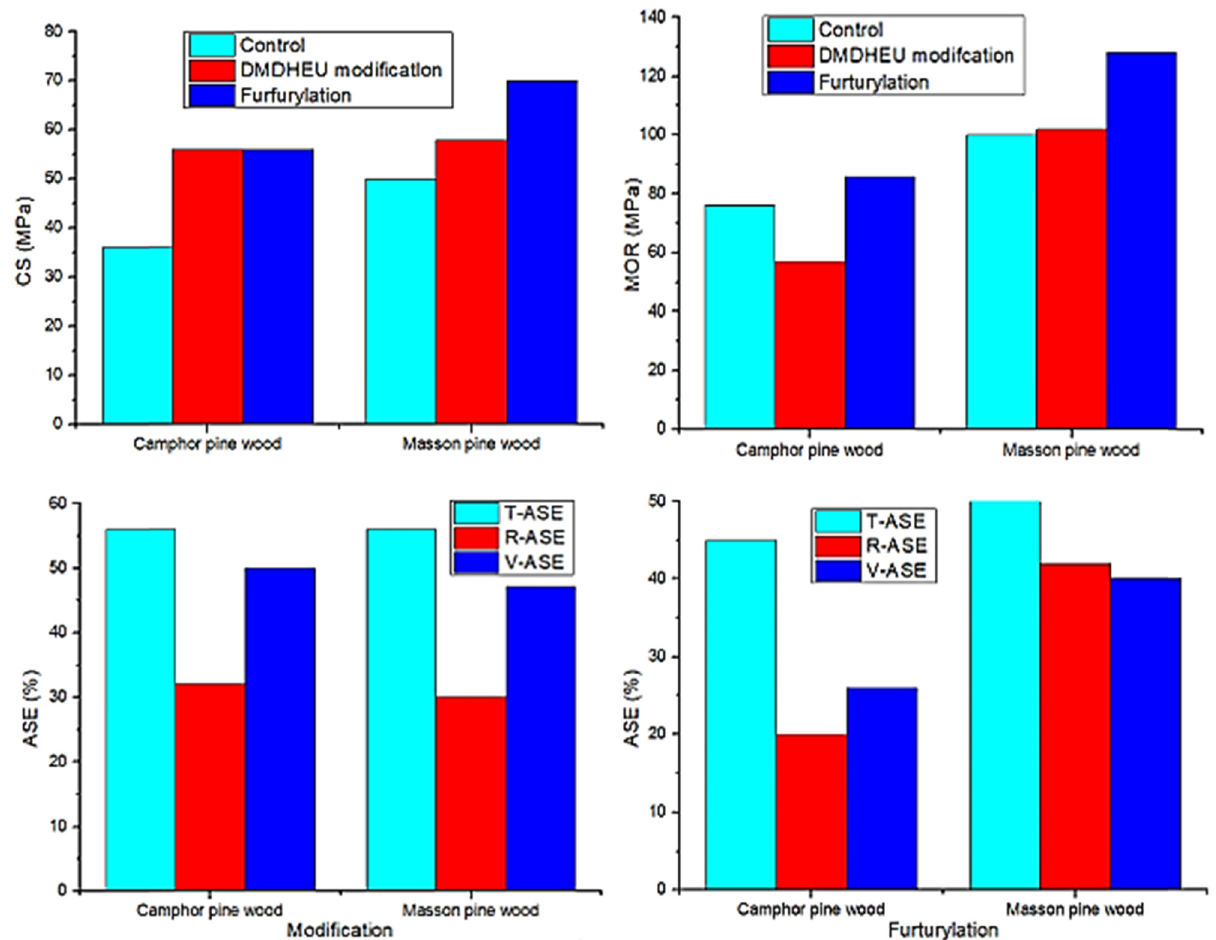
Figure 6: Comparison of properties of modi fi ed wood and unmodi fi ed wood [ 65 ]